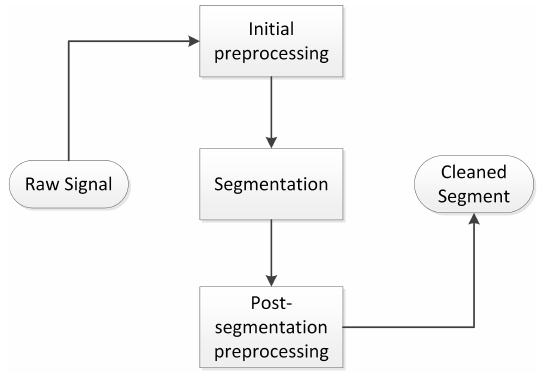
Figure 7. Preparing the signal for feature